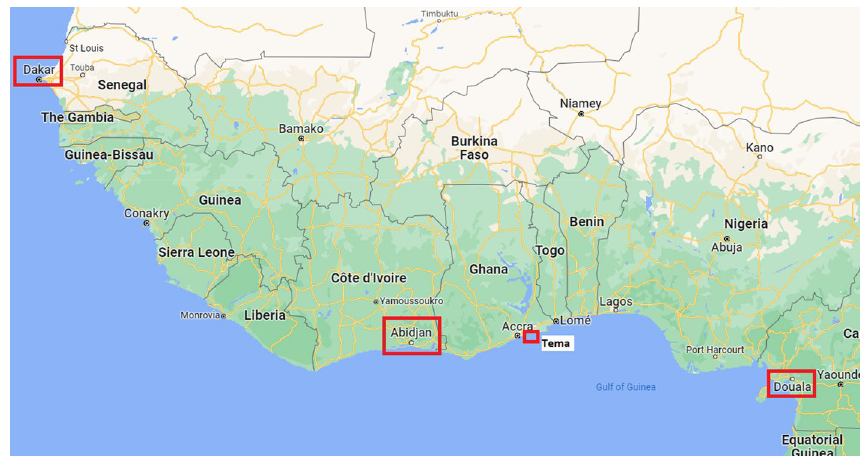
Fig. 1 Selected West-African ports. Source : author’s composition